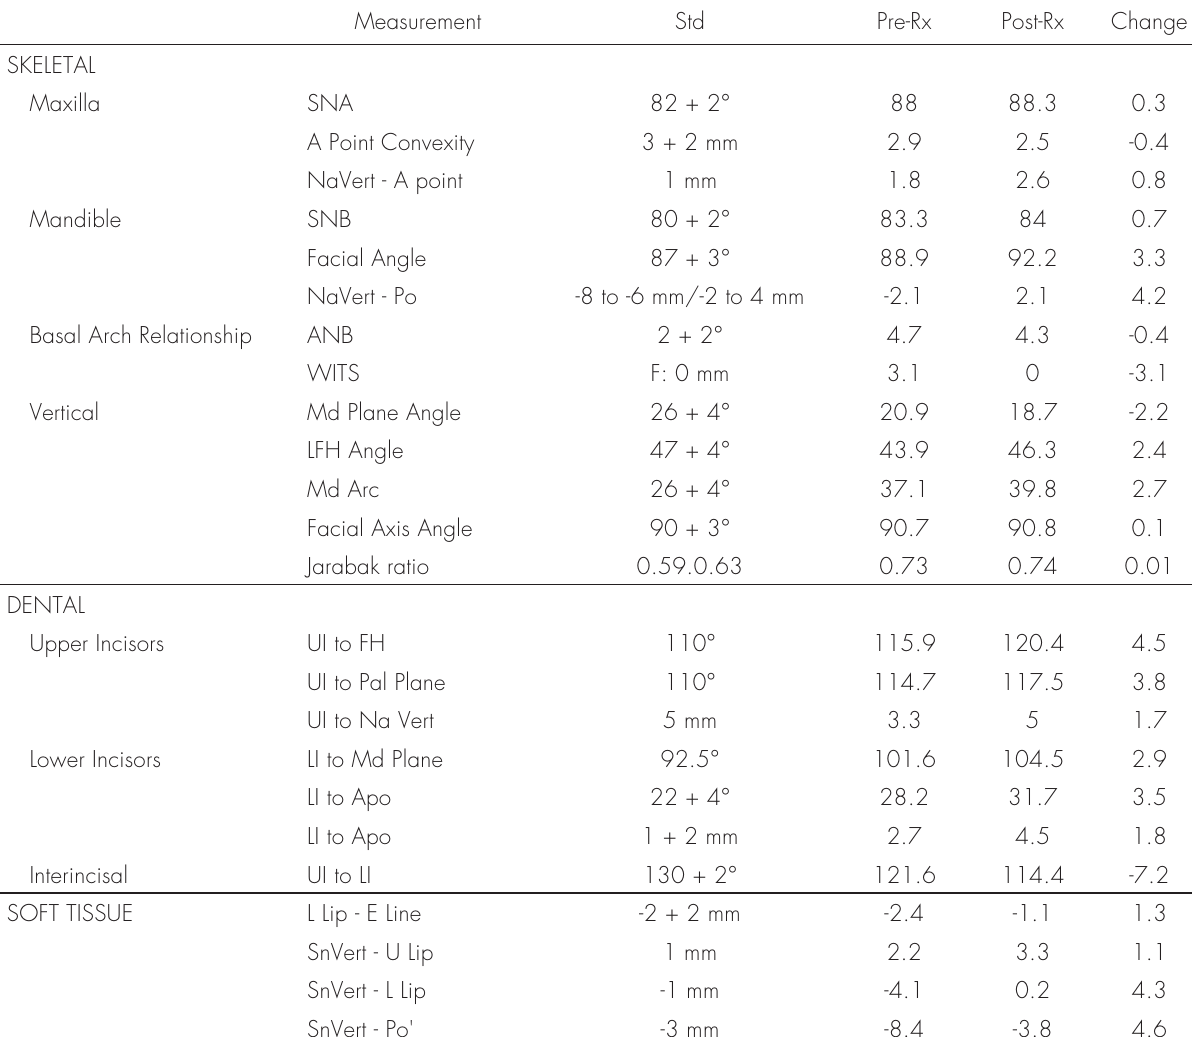
Table I. Cephalometric summary